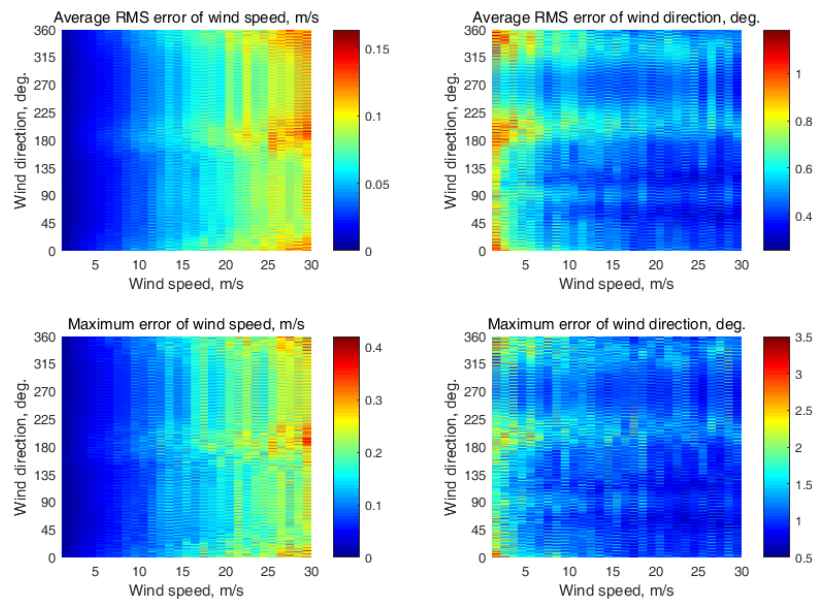
Figure A14. Semicircular wind retrieval results at the (55°, 60°) incidence angle combination.